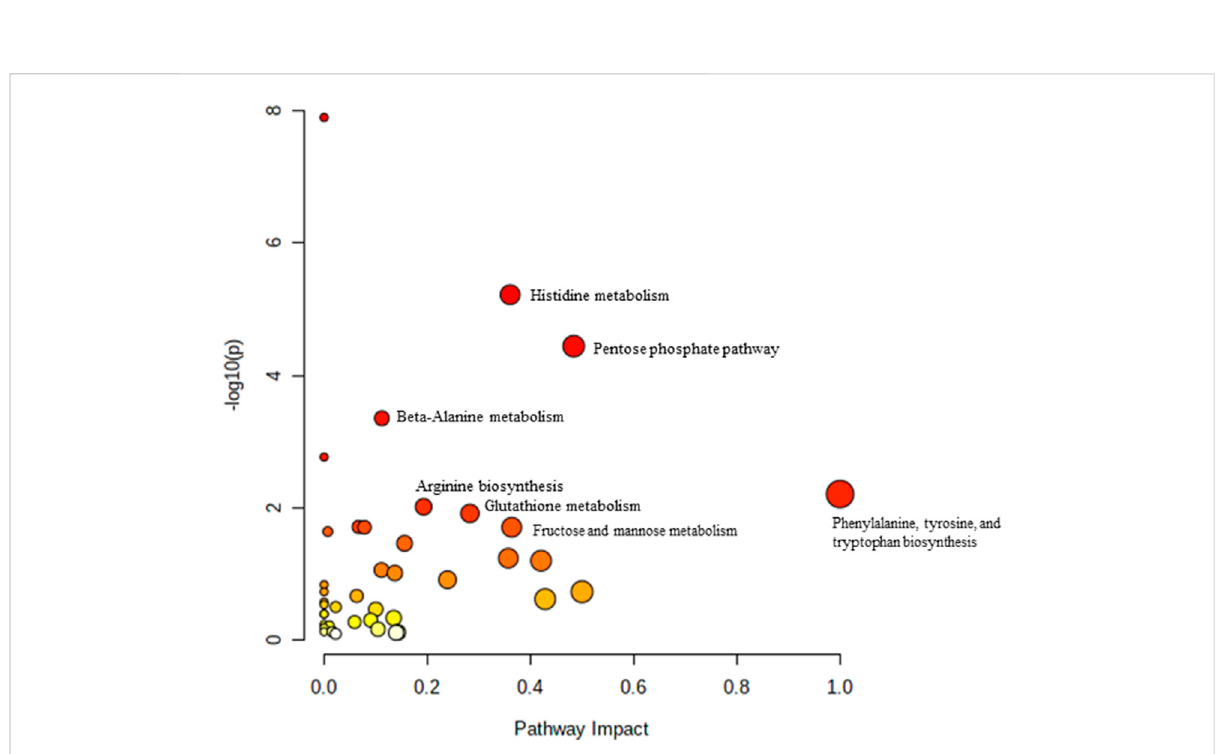
FIGURE 3 Biochemical pathway analysis of metabolites pro fi led for YC vs.